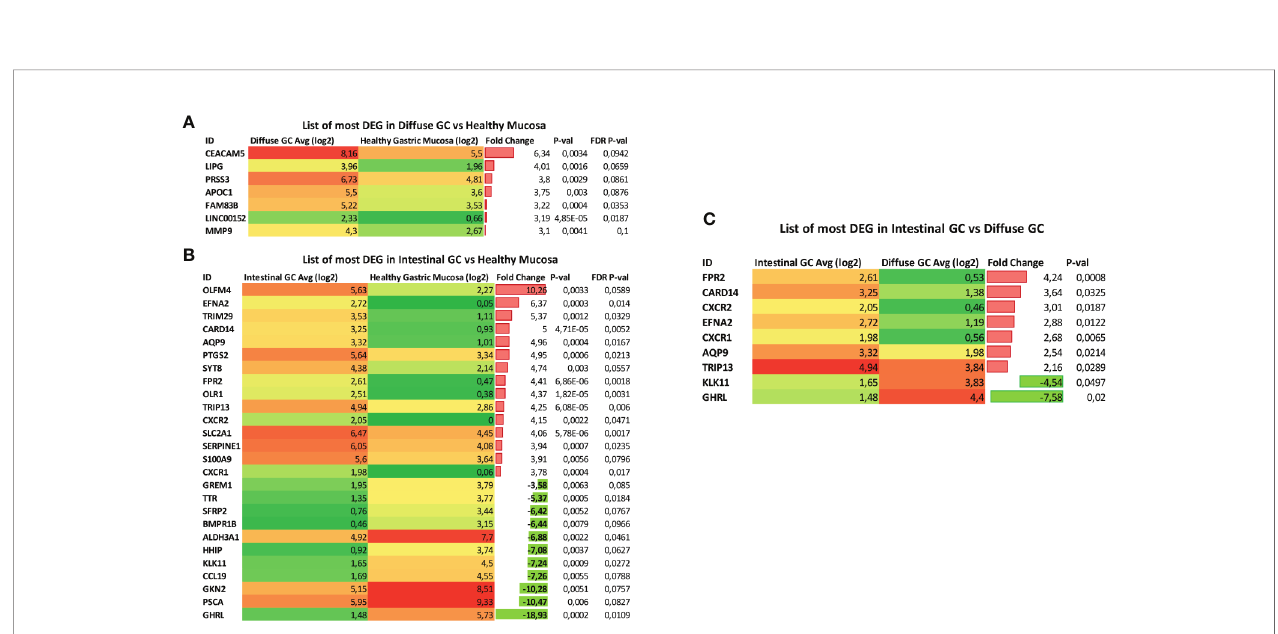
FIGURE 5 | Functional enrichment analysis of Histotype-speci fi c genes. Functional enrichment results of diffuse gastric-speci fi c genes and intestinal-speci fi c genes performed separately using DAVID